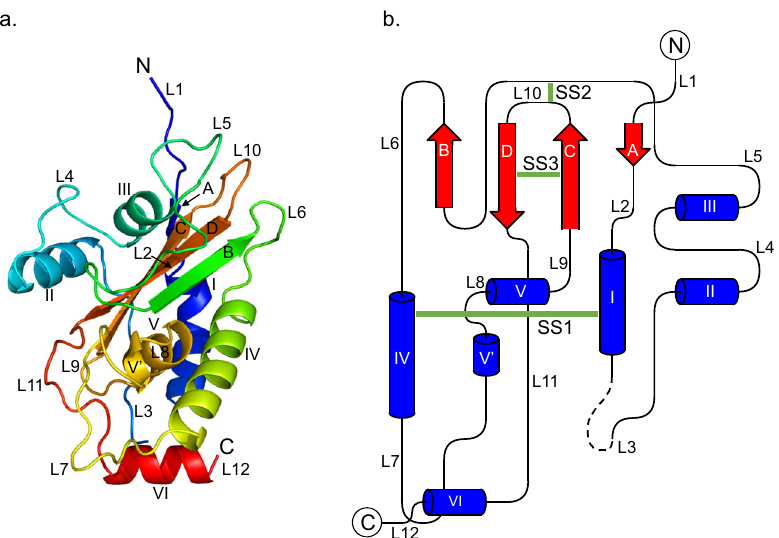
Fig. 1 3D structure of E. tenella SAG19. a Chainbow representation of the 3D structure of EtSAG19 indicating the structure consists of four β -strands (A – D), six α -helices (I – VI) and a single 3 10 helix (V ’ ). b 2D topology map of EtSAG19 with the N- and C-termini labelled. The locations of the three disulphide bonds are shown by green